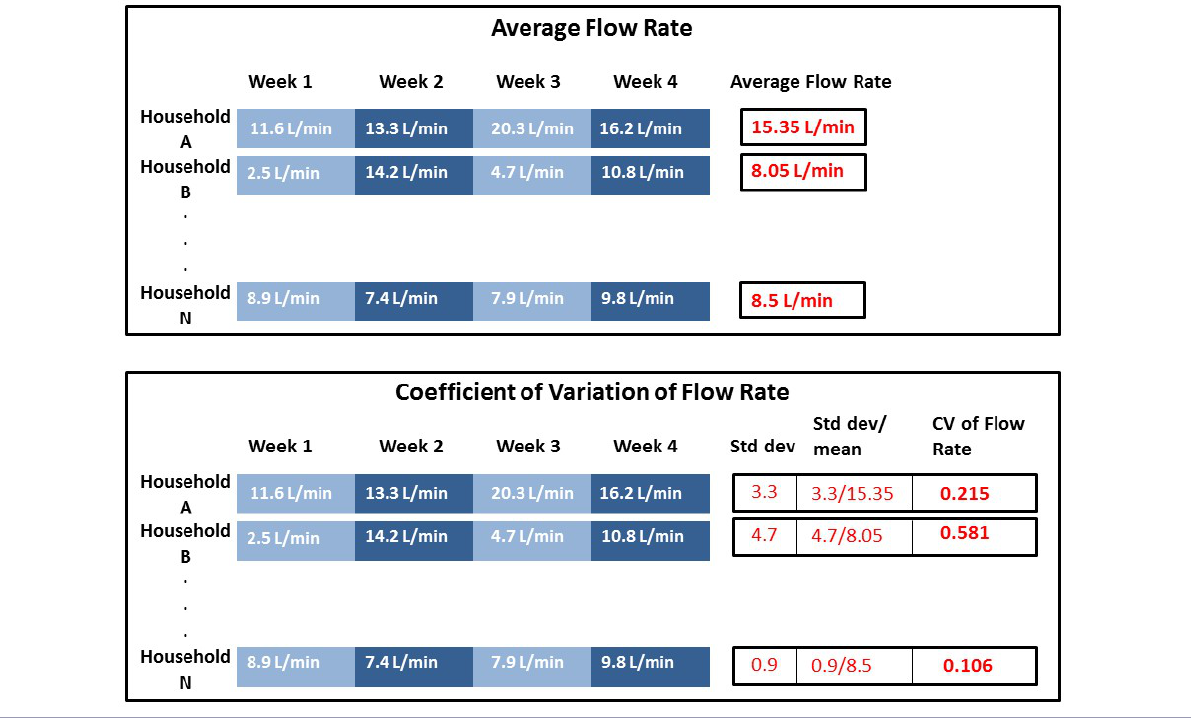
Fig. 3. Representation of steps to calculate average household flow rate (top schematic) and the coefficient of variation of household flow rate (bottom